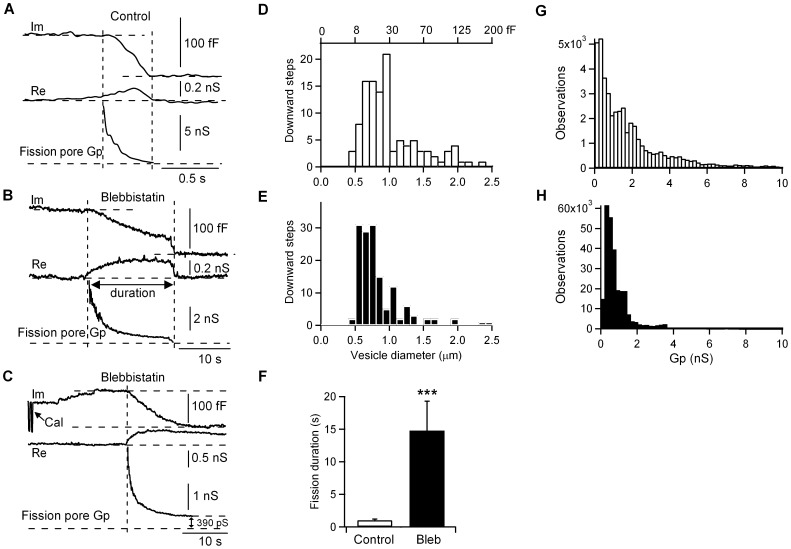
Effects of the NM-2 inhibitor blebbistatin on fission pore kinetics in mast cells.Representative fission pore events from control cells (A) and cells treated with 5 µM blebbistatin (B, C). The traces from top to bottom are the time course of the imaginary part of the admittance change (Im), the real part of the admittance change (Re) and the fission pore conductance (Gp). The horizontal and vertical dashed lines indicate the baselines of the respective signals and the duration of the fission pore, respectively. Two types of individual endocytic events were detected using perforated-patch capacitance measurements under NM-2 inhibition: a long event with detectable membrane scission (B) and an endocytic event without detectable pore closure, i.e., when a vesicle tries to undergo fission without closing completely (C). The change in the real trace during this type of event cannot be the result of an incorrect phase setting as demonstrated by the separation of Im and Re during a pure capacitance increase of 100 fF that was applied for online phase calibration (start of Im trace; Cal). The distribution of vesicle diameters were derived from endocytic capacitance step sizes from control cells (D, white) and blebbistatin-treated cells (E, black). Large downward steps associated with the retrieval of large areas of membrane (greater than one vesicle) were largely abolished (control: n = 124 events; blebbistatin: n = 148 events). Blebbistatin produced an increase in the fission pore duration compared to control cells (F). Frequency distribution of Gp values during fission pore closure of endocytic events from control cells (G, white) and blebbistatin-treated cells (H, black). Error bars, S.E.M. ***p<0.001.